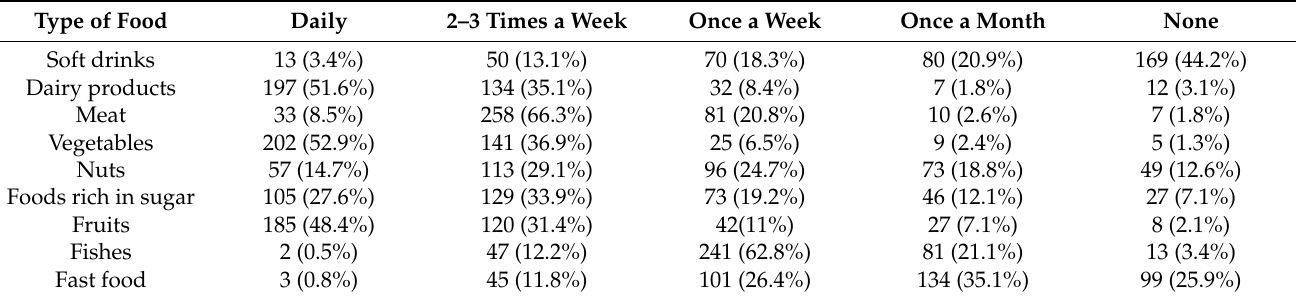
Table 4. Frequency and type of foods and drinks consumed by adults.